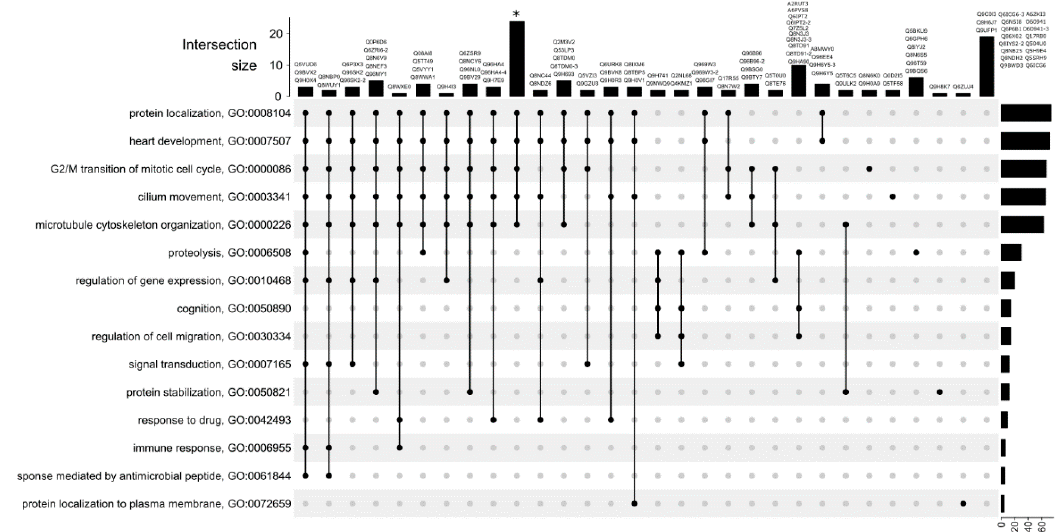
Figure 2. UpSet plot showing predicted biological processes. GO terms for Biological Process (BP) are represented as rows with barplots on the left showing total number of proteins annotated with specific term. Each column denotes proteins annotated with a specific set of GO-terms shown as dots (protein names are given at the top). * denotes the following set of proteins: O00193, O15481, Q53RE8, Q5THK1, Q68CR1, Q6P1M9, Q6P995, Q86X40, Q8IV32, Q8IW50, Q8N7X4, Q8NCJ5, Q8NCT3, Q8NCU4, Q8TBZ0, Q8TDY8, Q8WUB2, Q96BQ5, Q96GQ5, Q9BVG4, Q9H106, Q9H5V9, Q9H910, Q9Y546.